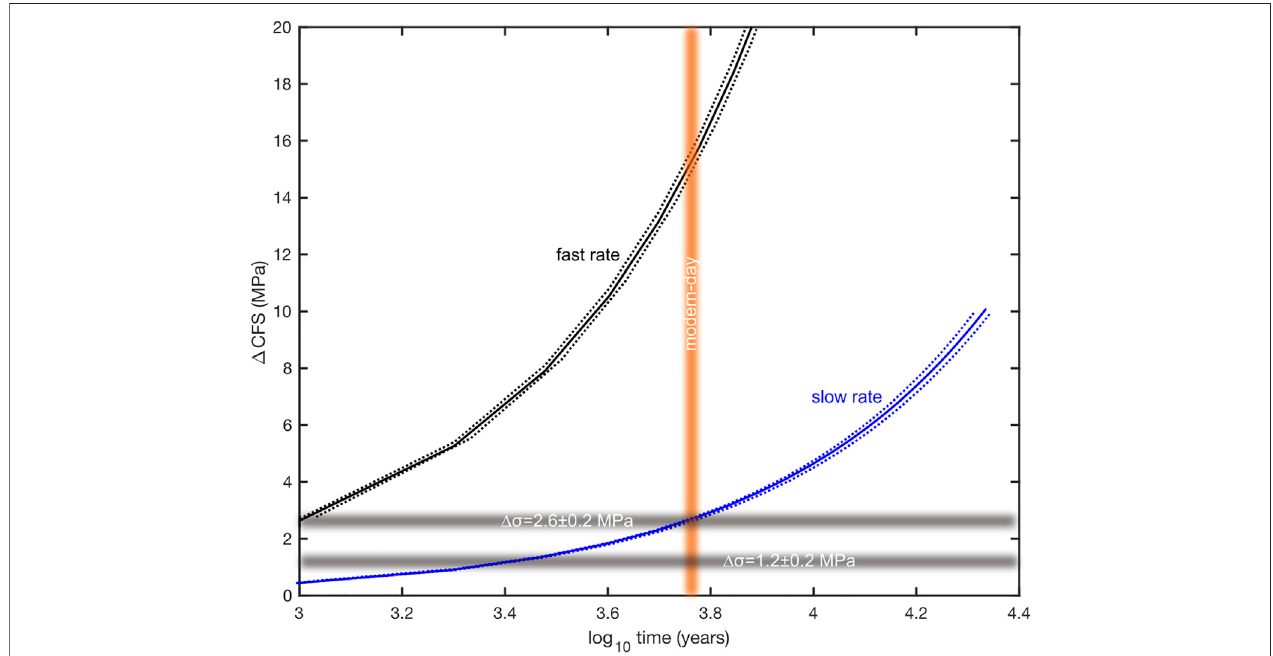
FIGURE 3 | Modeled Coulomb failure stress change accumulation Δ CFS ( Eq. 3 ) by gradual slip on the Akhisar-Kiliçc fault segment (AKFS) for the range of transtensional slip velocities reported by Krystopowicz et al. (2020) as a function of time elapsed since the most recent earthquake [5450 ± 160; using data from Kürçer and Gökten (2012)]. The vertical shaded area represents modern-day including data uncertainty and the horizontal shaded areas indicates stress drops Δ σ of 2.6 ± 0.2 MPa and 1.2 ± 0.2 MPa calculated for the range of moment magnitudes M w of earthquakes reported in Table 5 . The solid blue line shows the stress accumulation on the AKFS for a dextral slip rate of 0.58 mm yr − 1 (labeled slow rate) with a gradient of 450 ± 10 Pa yr − 1 . The solid black line shows the stress accumulation for a dextral slip rate of 3.35 mm yr − 1 (labeled fast rate) and a resultant gradient of 2700 ± 67 Pa yr − 1 . Both scenarios have a normal slip rate of 0.05 mm yr − 1 . Uncertainties are expressed by dotted